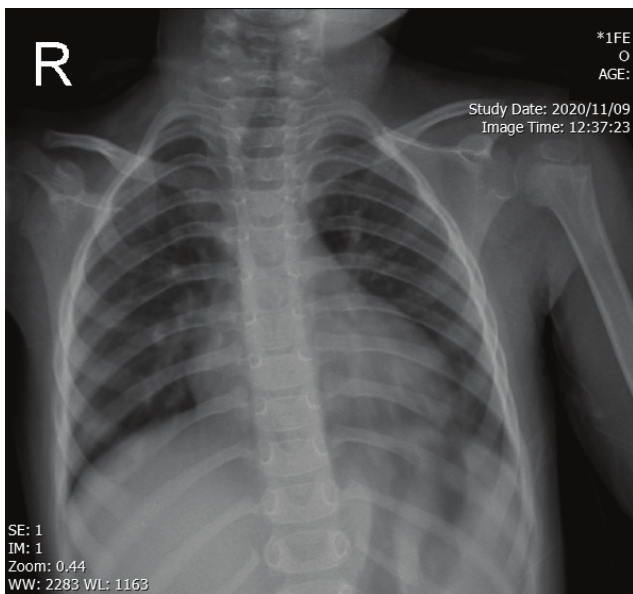
Figure 1 : Chest radiograph of the three-year-and-three-month-old child with aplastic anemia (day 1 of